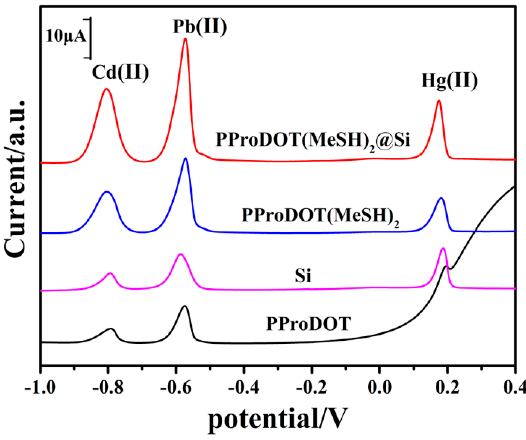
Figure 6. Differential pulse voltammetry (DPV) response curves of different modified glassy carbon electrode (GCE) in 0.1 M ABS (pH = 4.5) containing 1.0 µ M of Pb(II), Cd(II) and Hg(II) (deposition potential: − 1.4V, deposition time: 180 s, amplitude: 0.05 V, increment potential: 0.002 V, pulse width: 0.05 s, pulse period: 0.1s).